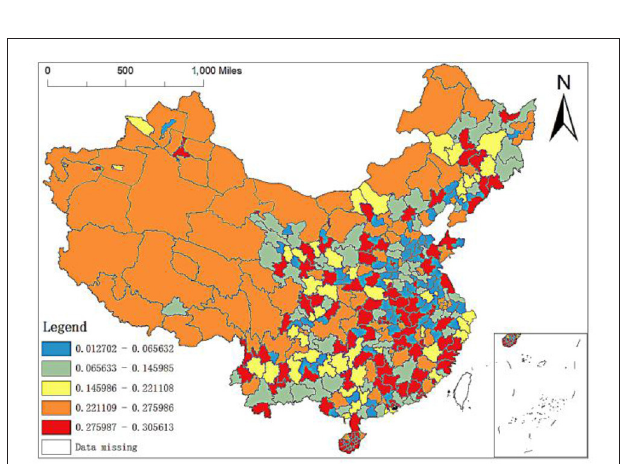
FIGURE 7 | Spatial distribution of regression coefficients of GDP per capita.